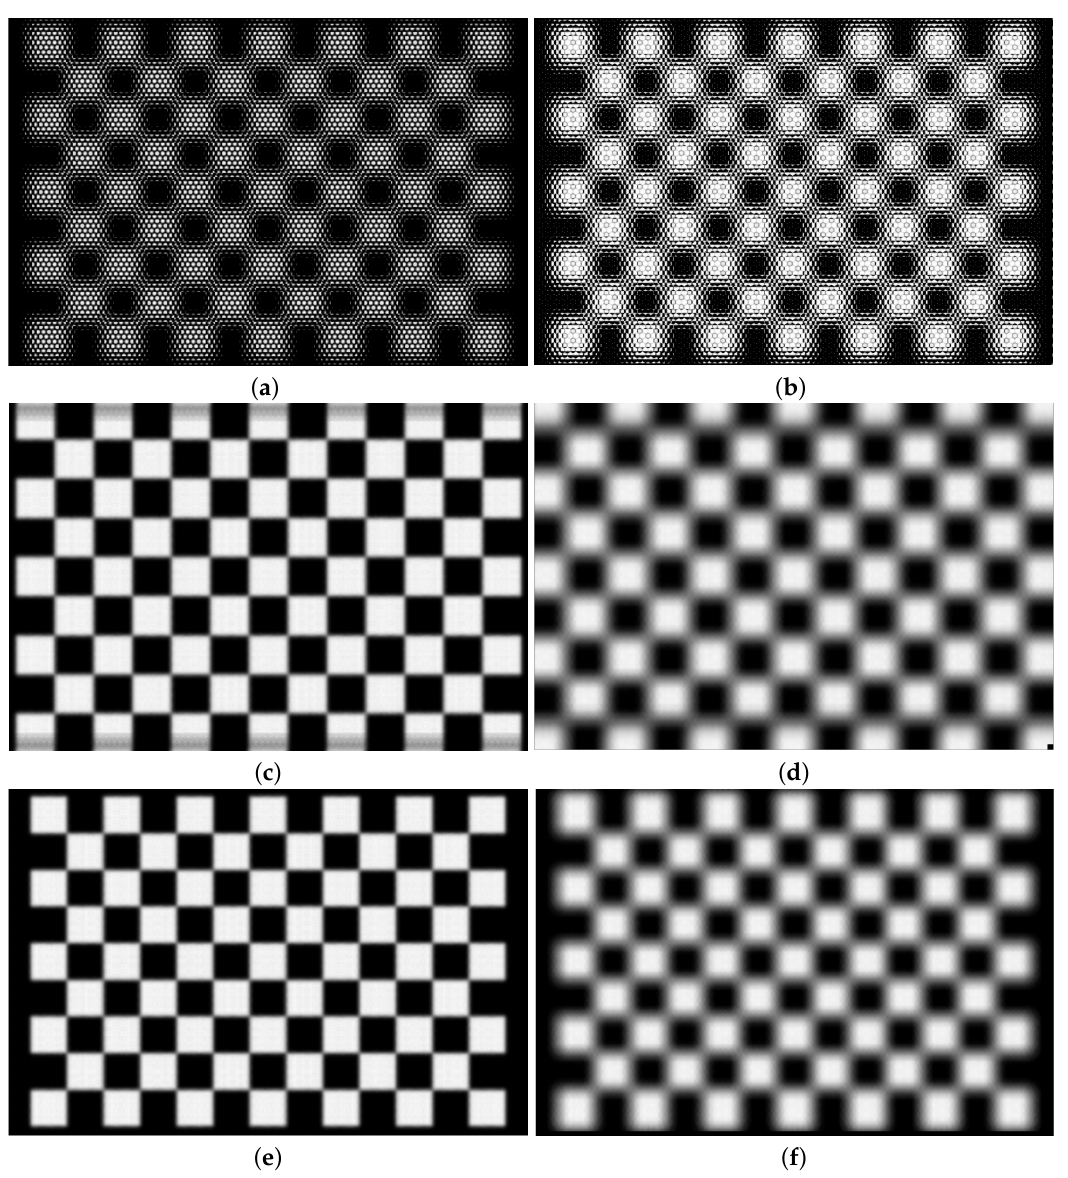
Figure 6. Simulated results of refocusing experiment. ( a ) Simulated raw image with vignetting. ( b ) Simulated raw image without vignetting. ( c ) Traditional refocused image at v F = − 6. ( d ) Traditional refocused image at v F = − 12. ( e ) Our refocused image at R F = − 5.64. ( f ) Our refocused image at R F = −